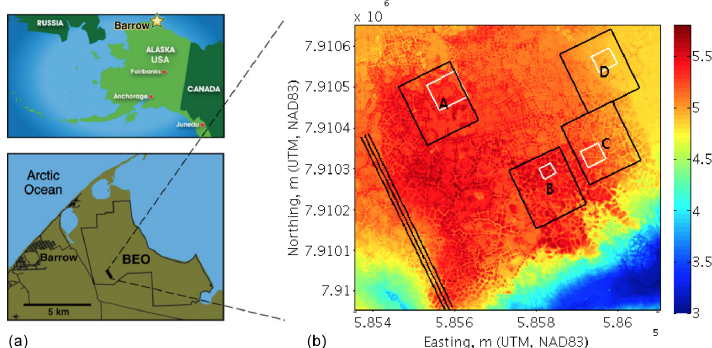
Figure 1. (a) Location of Barrow, Alaska, USA, and Barrow Environmental Observatory (BEO) from Hubbard et al. (2013). (b) NGEE Arctic site with the digital elevation map from the airborne lidar (in meters). The black boxes are the intensive sampling plots (plots A, B, C and D). The white rectangles are the fine-grid snow depth measurements by a snow depth probe. The three black lines represent the 500m